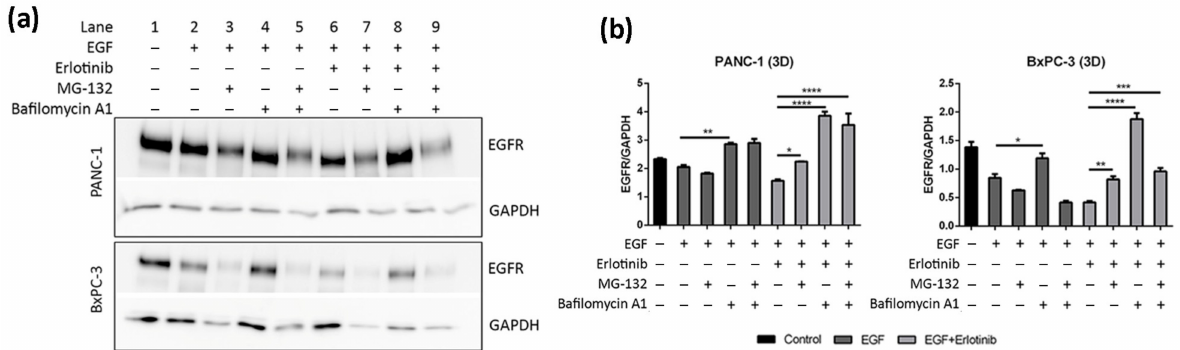
Figure 8. Western blot analysis of the EGFR in PANC-1 and BxPC-3 cells incubated with EGF and erlotinib in the presence of the proteasome (MG-132) and lysosomes (Bafilomycin A1) inhibitors in 0.15% RAD16-I 3D cultures. ( a ) Western blot bands of EGFR; ( b ) densitometry of bands shown in ( a ). GAPDH was used as an internal control. One representative blot is shown. Experiments were repeated three times (N = 3), and statistical differences are indicated as * for p < 0.05, ** for pv<0.01, *** for p < 0.001 and **** for p <